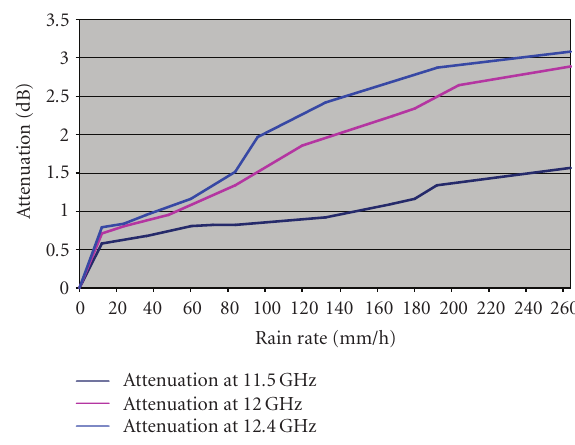
Figure 5: The attenuation versus rain rate at elevation angle 51 via three